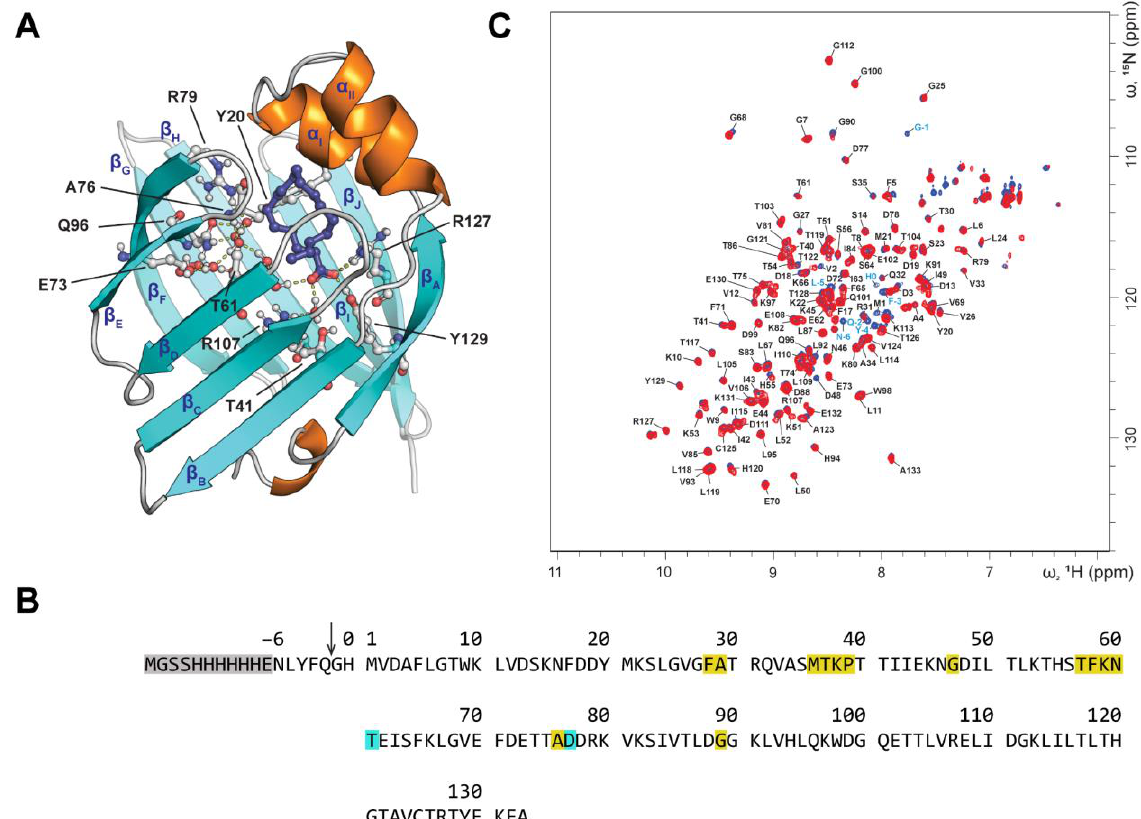
Figure 1. ( A ) Structure of heart-type fatty acid-binding protein (FABP3, PDB ID 3WVM [15]) in complex with palmitate (C16:0). Protein structure is represented as ribbons and colored according to the secondary structure elements as follows: α - helixes shown in orange, β -sheets in cyan, and loops in gray. C16:0 is shown as dark blue sticks, while residues involved in ligand and water cluster binding are shown as light gray balls and sticks. Water molecules (red spheres) and hydrogen bonds (yellow dashed lines) are shown. ( B ) Human FABP3 amino acid sequence. Residues colored in yellow were not assigned from the NMR spectra either for the apo-form or for the holo-form, while residues in cyan were not assigned only for complexes of FABP3 with acylcarnitines (ACs). Crosspeaks for residues colored in gray were not observed in any 2D 1 H- 15 N HSQC spectra. The black arrow points to the position of the TEV cleavage site. ( C ) Assigned 2D 1 H- 15 N HSQC spectra of human apo-FABP3 in 20 mM K 2 HPO 4 /KH 2 PO 4 , 50 mM KCl buffer pH 7.6 (KPi). His-tagged FABP3 (noncleaved) is shown in blue, and cleaved FABP3 is shown in red. Backbone amide resonances are denoted as one letter symbol and residue number according to the sequence in Figure 1B. Labels for the residues from the His-tag are shown in light blue. Side chain amide resonances were not assigned. Residues are numbered according to UniProt ID P05413.